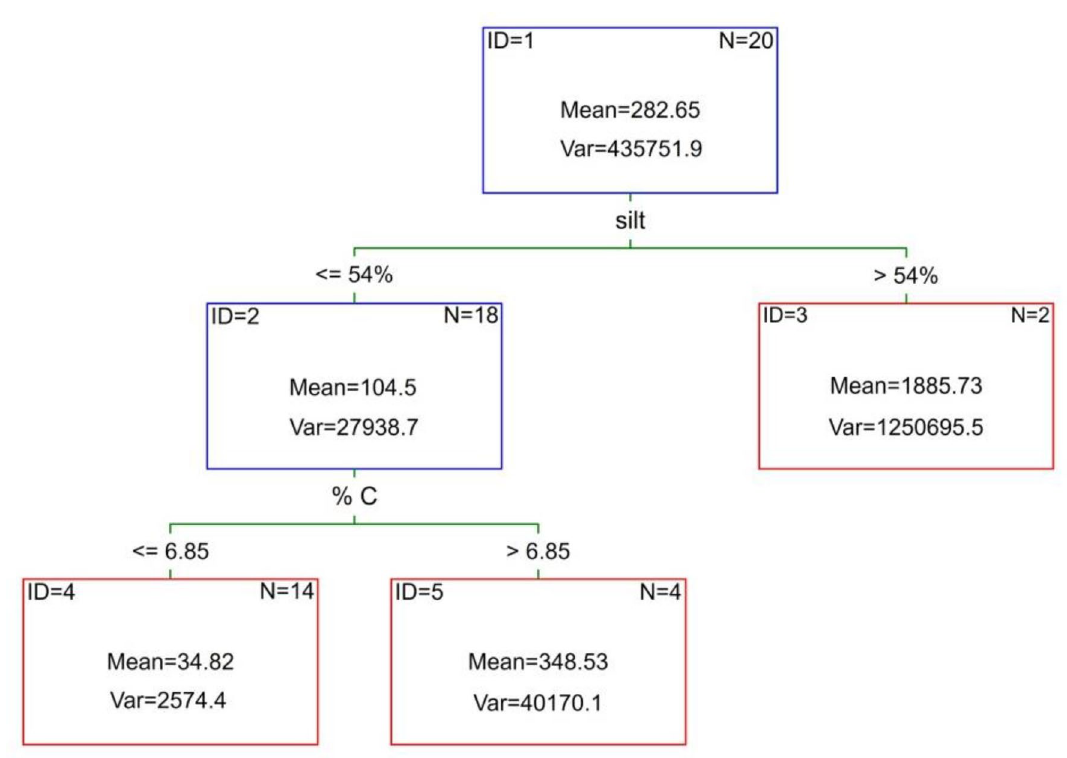
Figure 5. The regression tree (C&RT) for PAHs content in soils, was generated using Statistica 13